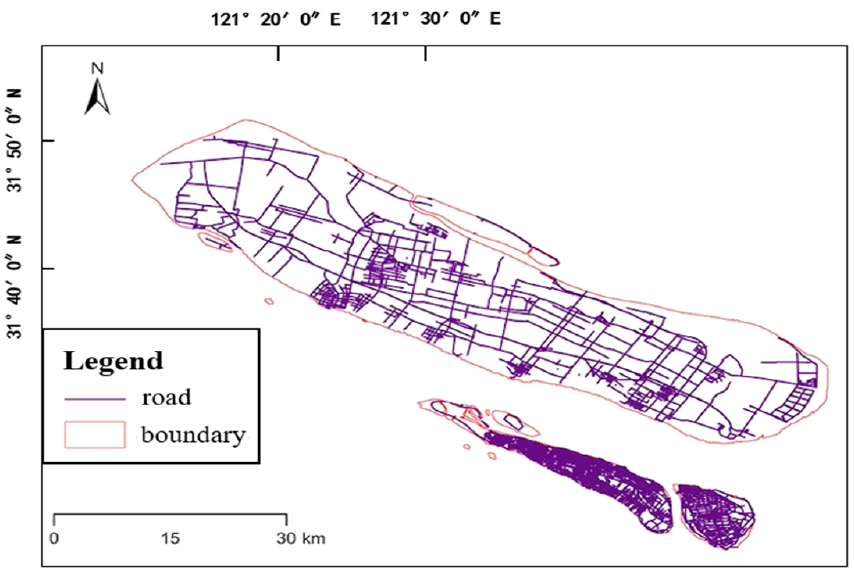
Figure 7. Road networks in Chongming District.